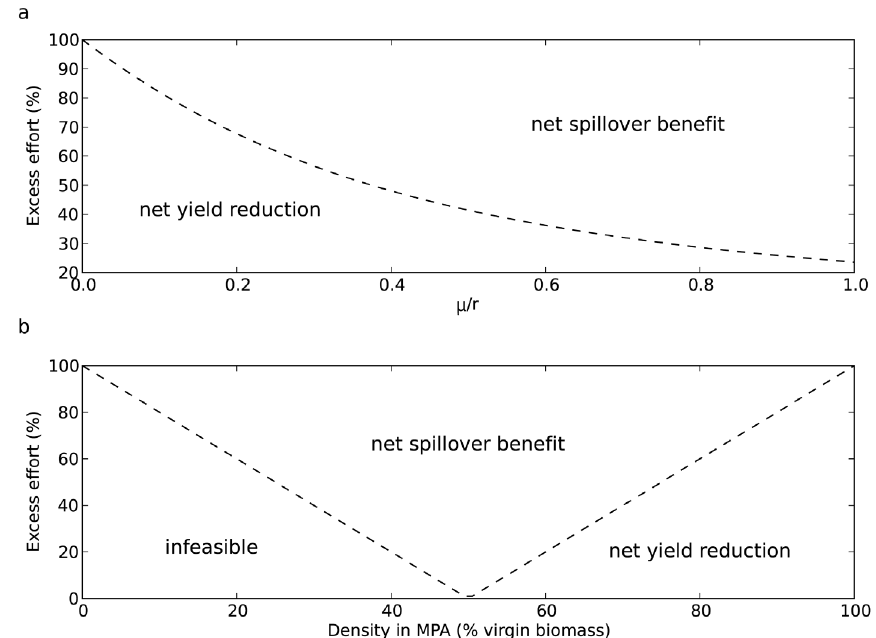
Figure 2. Characterisation the management and biological circumstances in which a reserve is beneficial. (a) The excess effort required for a reserve to improve fishery yield. For our simple model this was found to depend only on the ratio of the movement rate out of the reserve (and thus on reserve size) to the growth rate of the stock ( m = r ). (b) The excess effort required for optimality as a function of the reserve density (at equilibrium). For example a reserve with 80% virgin biomass at equilibrium will provide a net economic benefit for a fishery that has more than 60% excess effort relative to optimal management. Combinations of excess effort and reserve density that fall in the bottom left region are infeasible; in these situations a reserve would have to decrease in population density after being formed (not possible in our model). Inside the ‘‘V’’ the reserve provides a net increase in fishery yield. In the right region the reserve decreases yield.